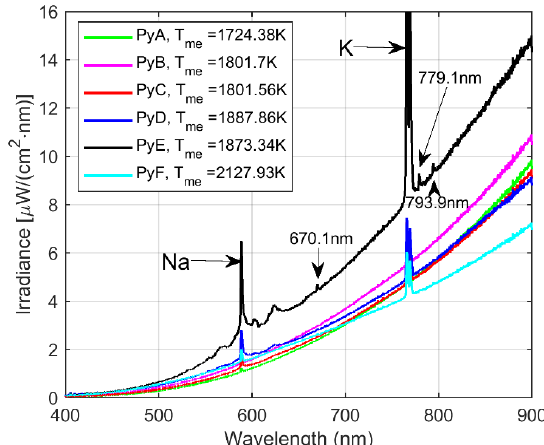
Figure 4. Average spectral emission from pyrite minerals in combustion experiments by considering di ff erent particle sizes.